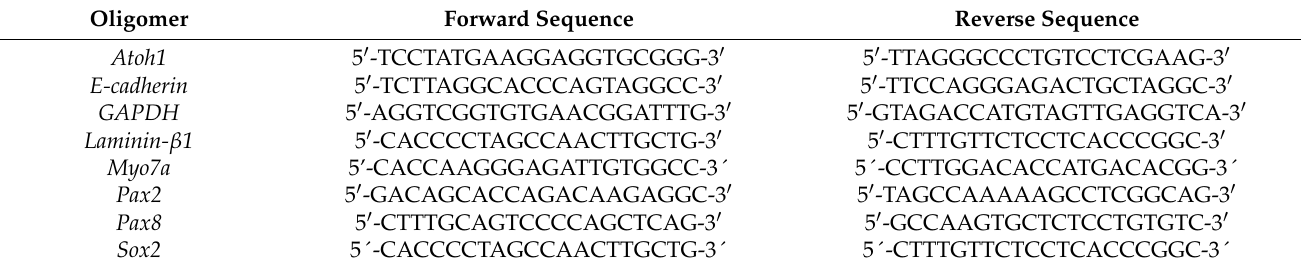
Table 2. Oligomers associated with differentiation marker into inner ear-like